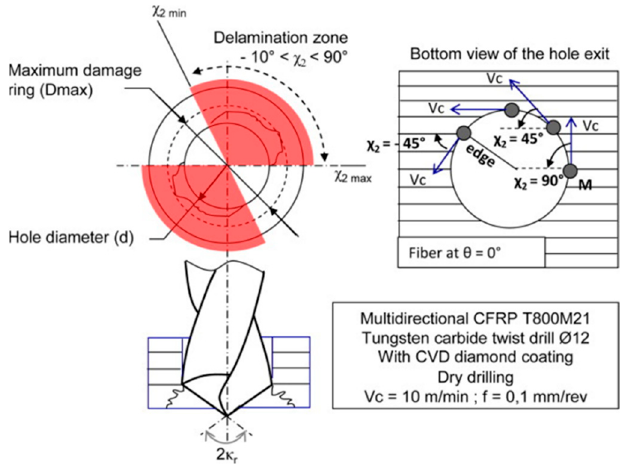
Figure 3. Definition of damage criteria during CFRP drilling